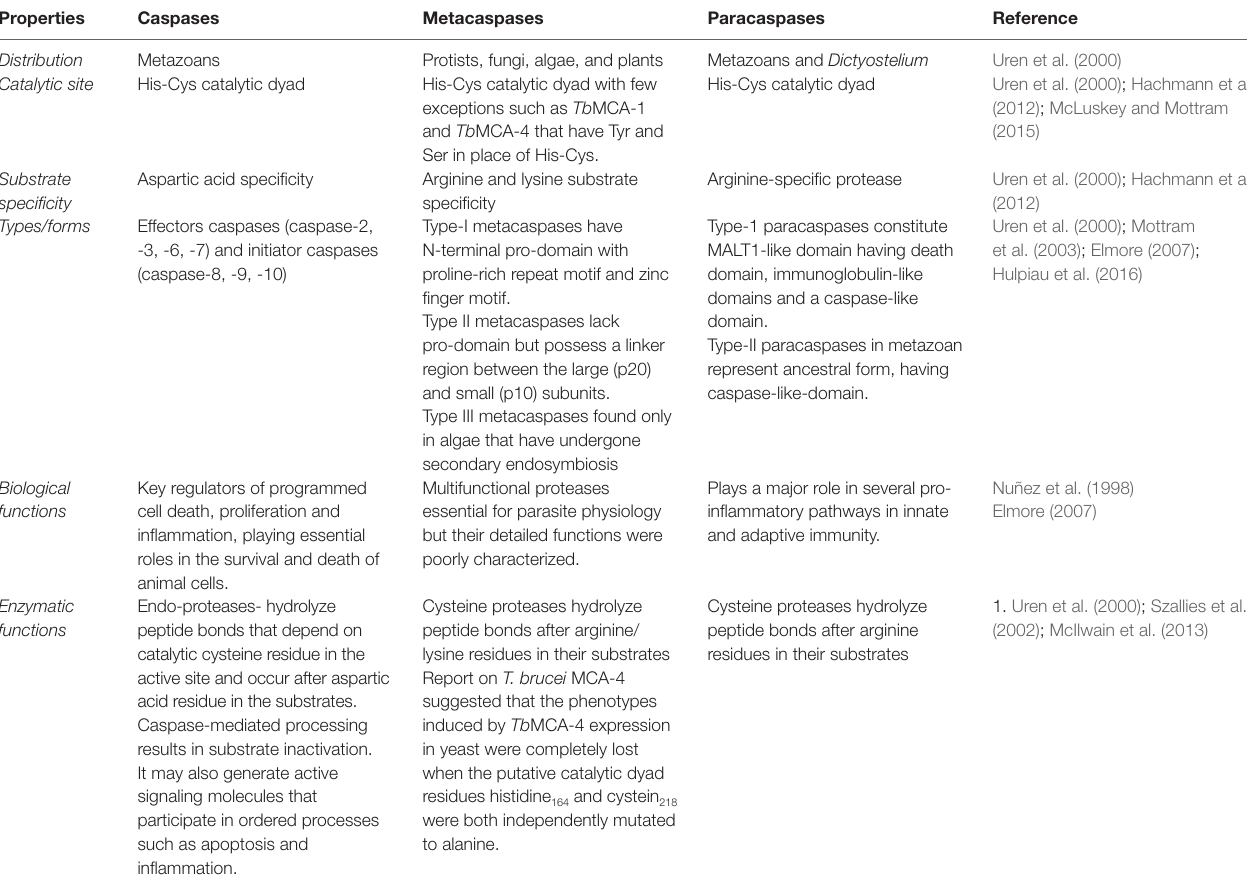
TABLE 1 | Comparative analysis of key properties of caspases, metacaspases, and